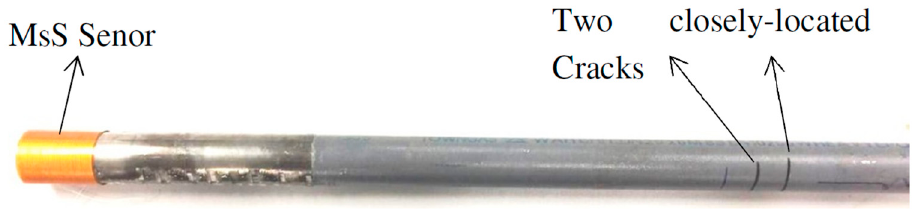
Figure 16. The real gas pipe with two closely located cracks.